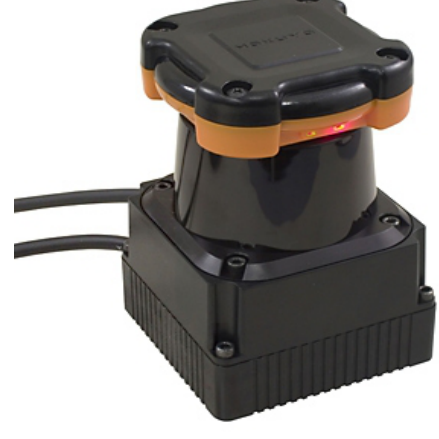
Figure 2. First used laser scanner (Hokuyo